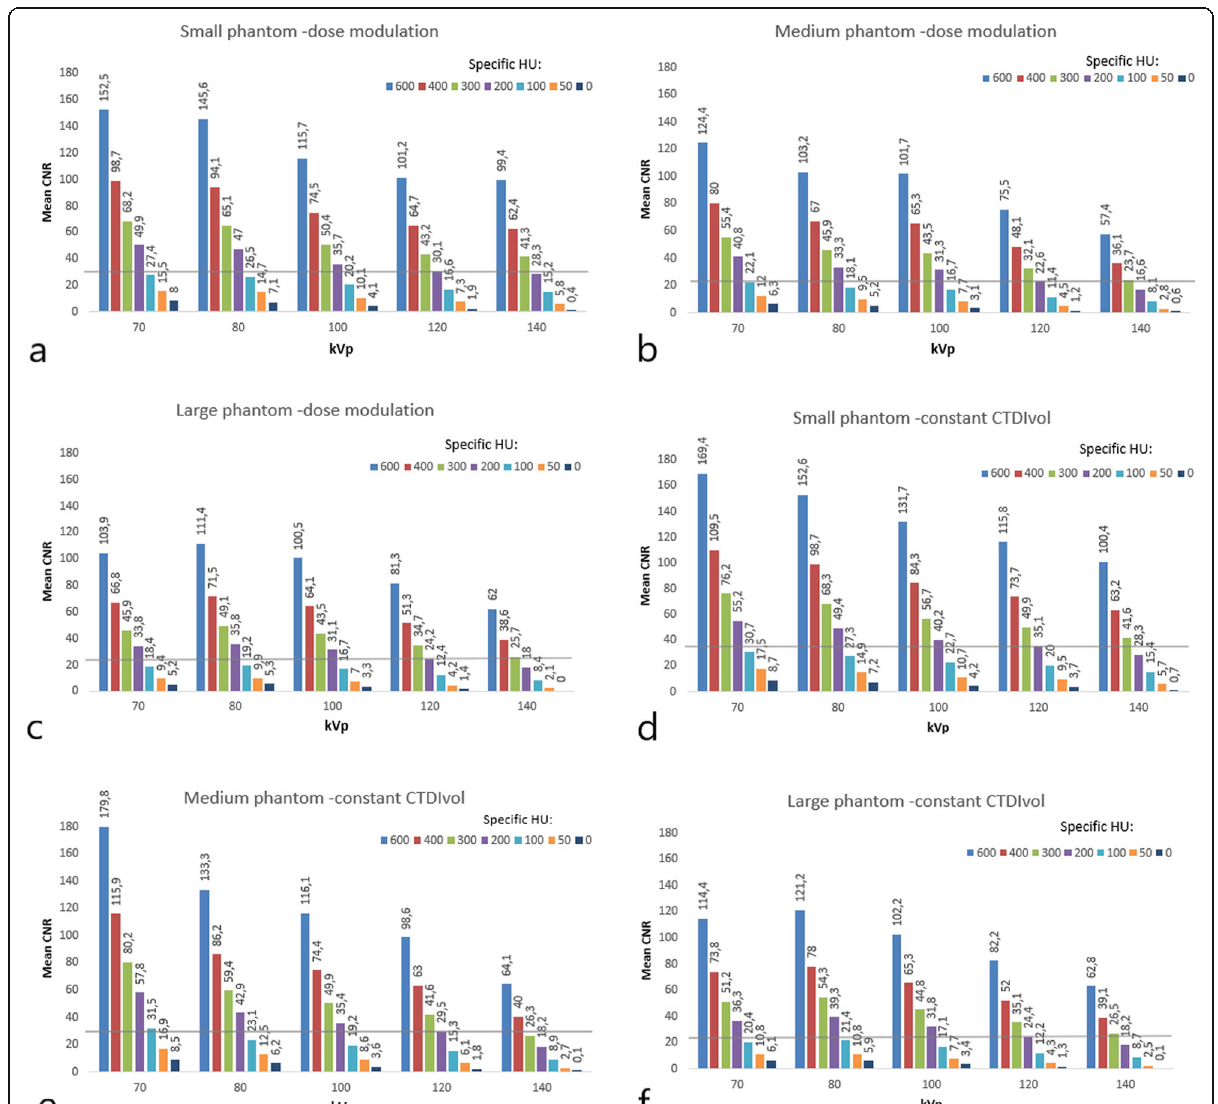
Fig. 3 Mean contrast-to-noise values measured for the specific HU between 0 and 600 HU at tube potentials between 70 – 140 kVp when using dose modulation ( a , b and c ) and a constant volume computed tomography dose index (CTDIvol) ( d , e and f ) for the three different phantom sizes. The horizontal line displays the diagnostic contrast enhancement level ≥ 200